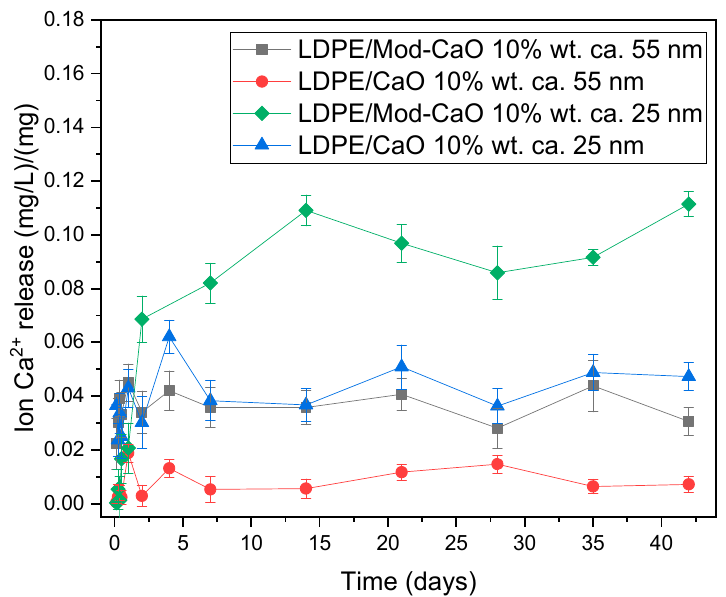
+ release from LDPE / CaO (10 wt% CaO) as a function of time after 42 Figure 9. Ca 2+ release from LDPE/CaO (10 wt% CaO) as a function of time after 42 days. Figure 9. Ca 2